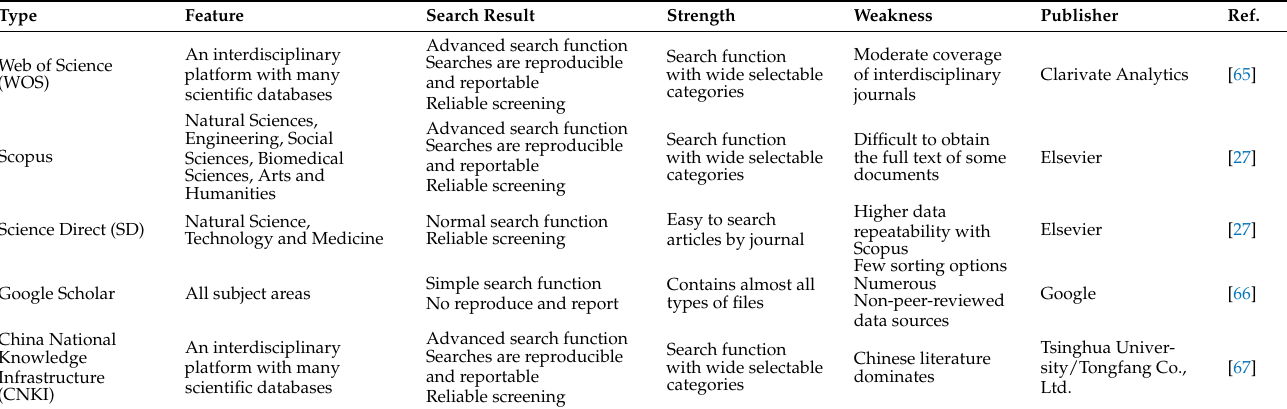
Table 3. Bibliographic database source